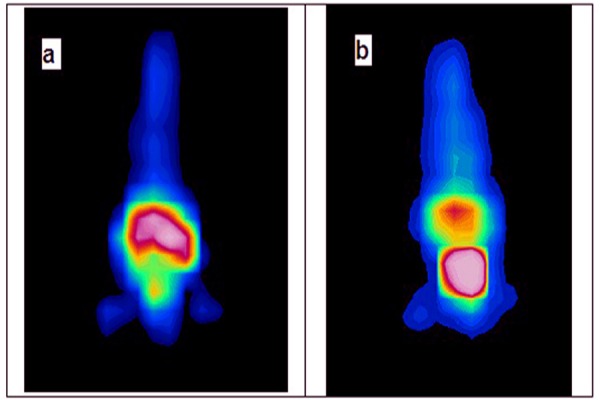
Planar images of Syrian rat at 30 min (a) and 120 min (b) after intravenously injection of 68Ga-DOTATOC (5.55 MBq)